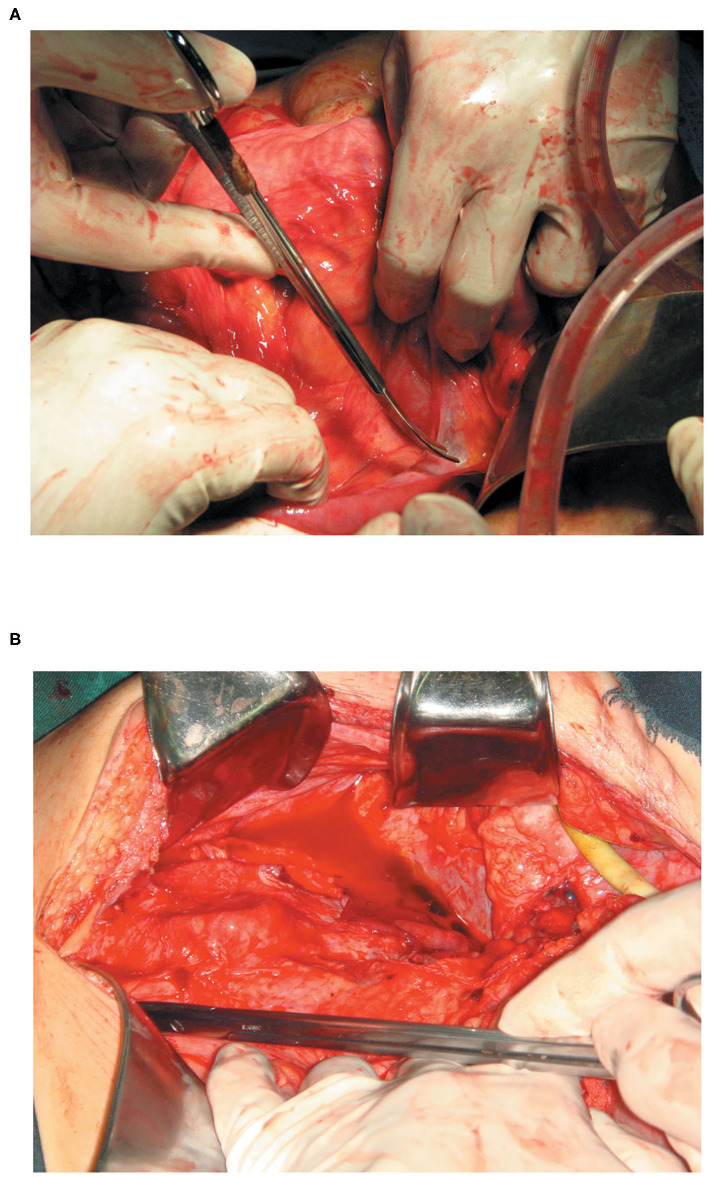
(A) With grade IV intestinal adhesions (diffuse extensive adhesions and easily lysed) more than 50% of the intestinal tract in the abdominal cavity was adherent, with poor dissociation. However, the shape of the intestine in the area could be identified, and could be easily lysed. (B) With grade V intestinal adhesions (diffuse extensive, dense adhesions, and difficult to lyse) more than 50% of the adhesions tissue between the two segments of the intestine was invaded by abundant capillaries, and the shape of the intestine in the area could not be identified.